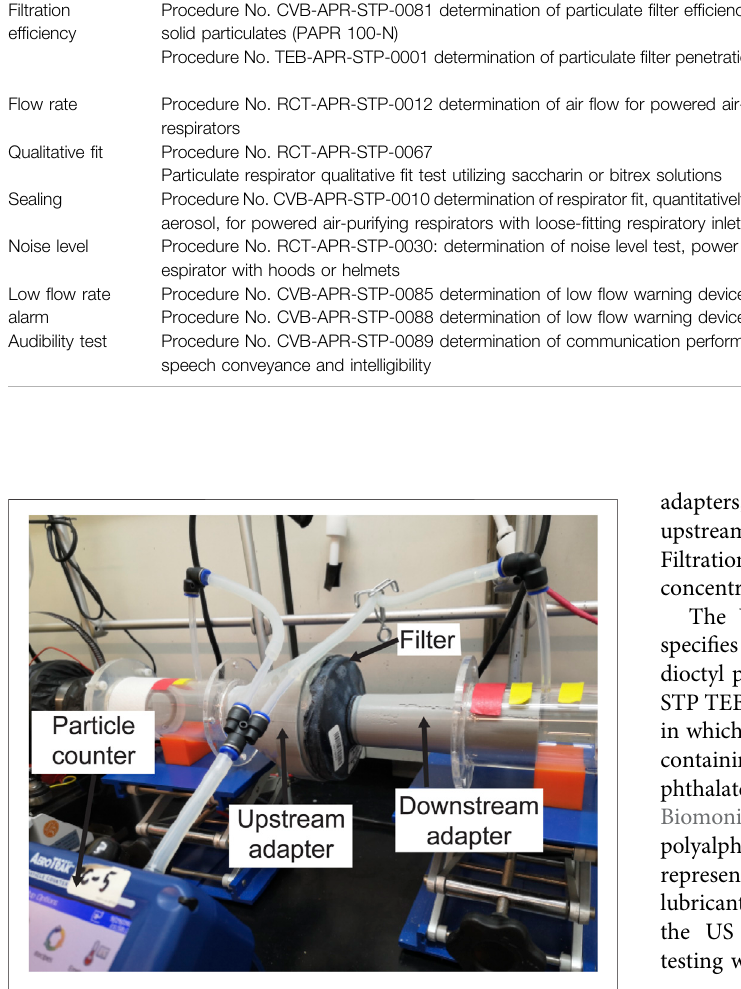
fi ltration ef fi ciency of N95-type FFRs ( Figure 2 ). Due to the